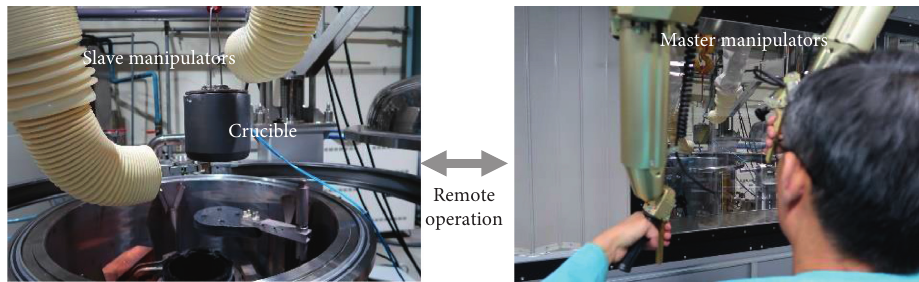
Figure 7: Moving crucible filled with copper ingots using MSMs and crane.